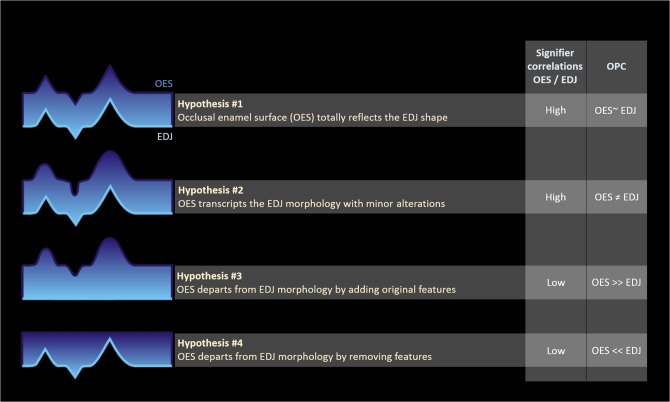
Working hypotheses on the relationships between OES/EDJ morphologiesOES, occlusal enamel surface; EDJ, enamel-dentine junction; OPC, orientation patch count The four hypotheses on how the OES echoes EDJ morphology are considered Following hyp#1 the correlation between the EDJ and the OES is expected to be total and both organs are expected to show the same amount of occlusal complexity (OPC); hyp#2, the correlation between the EDJ and the OES is expected to be high and both organs are expected to show different amount of occlusal complexity; hyp#3, the correlation between the EDJ and the OES is expected to be low and the OES is expected to show greater amount of occlusal complexity; hyp#4, the correlation between the EDJ and the OES is expected to be low and the OES is expected to show lower amount of occlusal complexity.